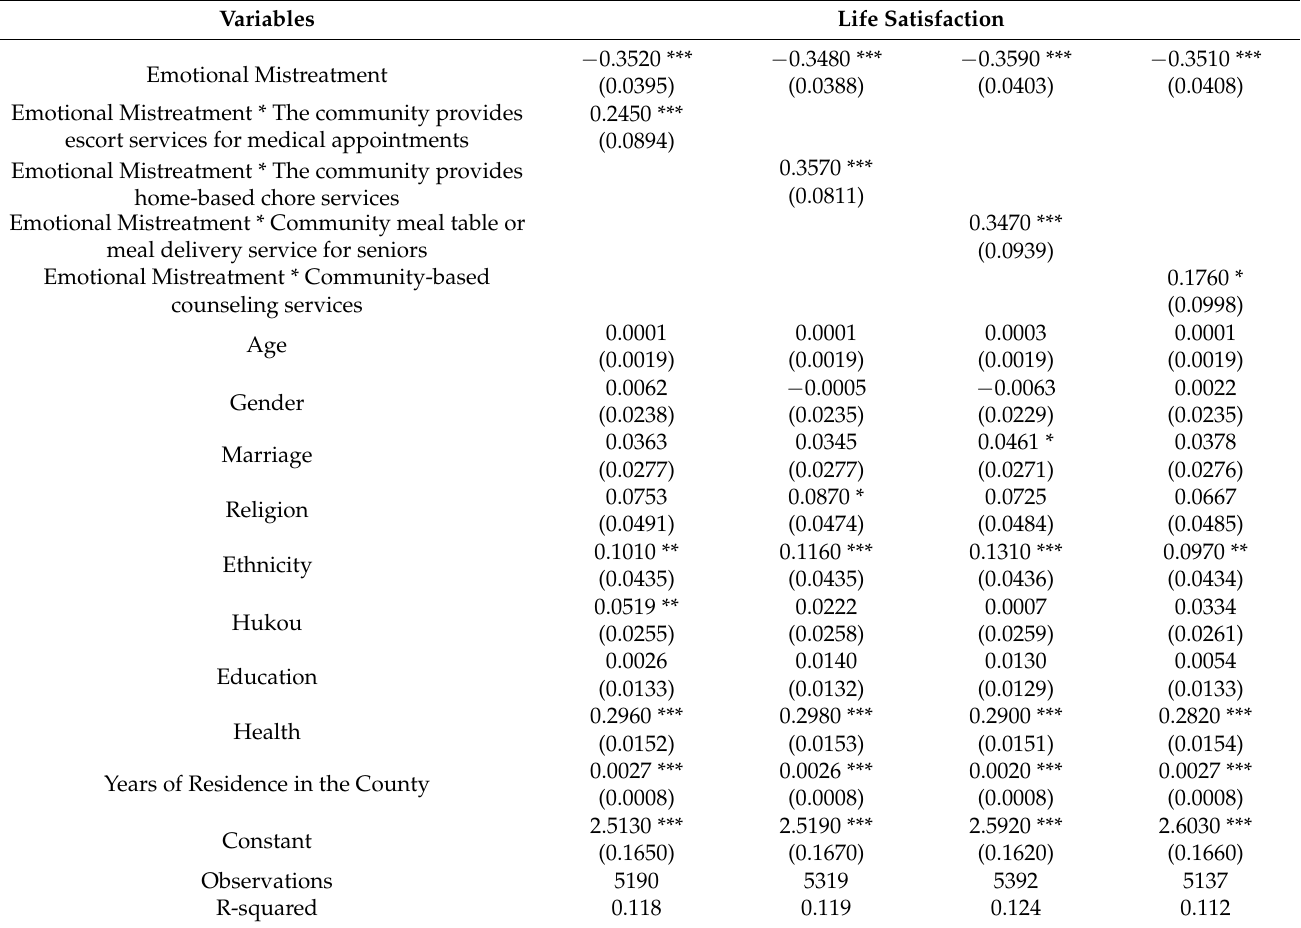
Table 7. Mitigation role of community